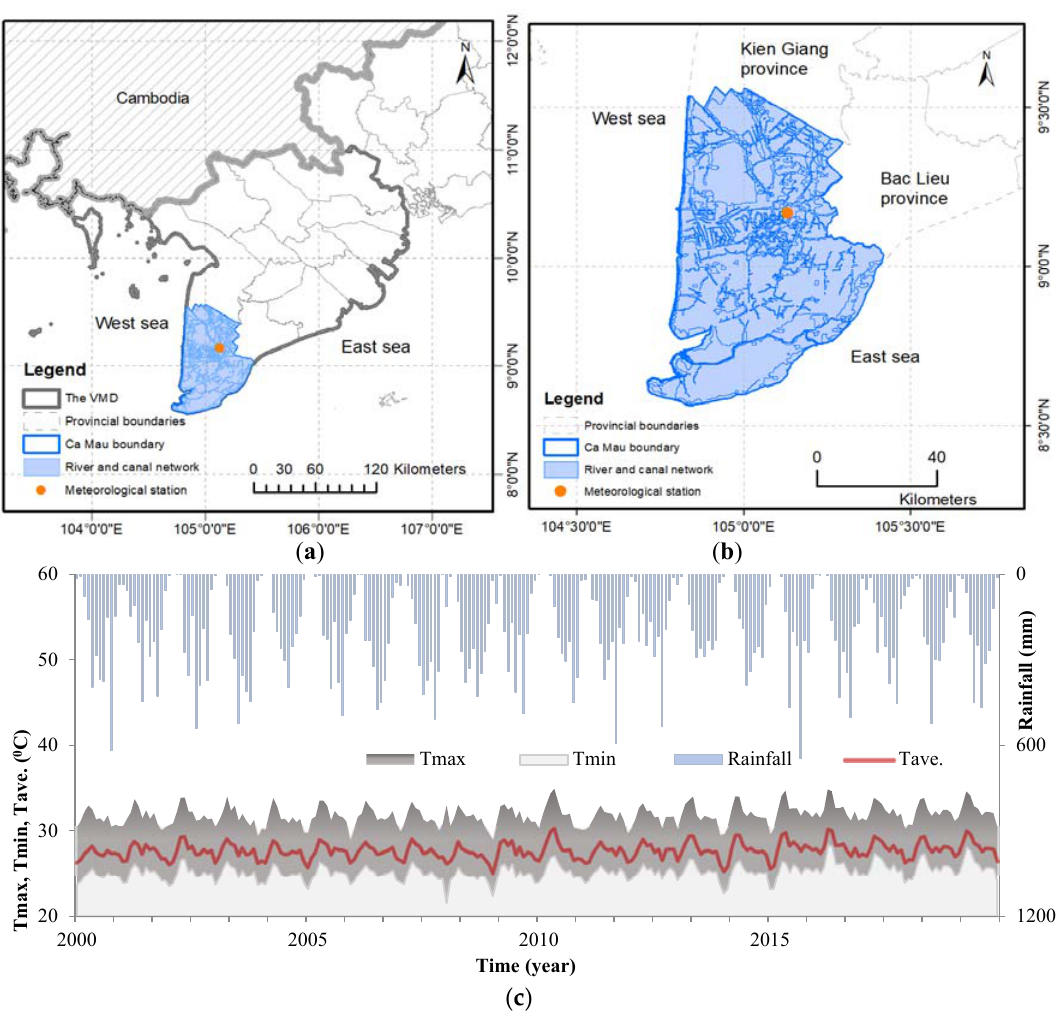
Figure 1. Location of Ca Mau province ( a ) and meteorological station ( b ); and T max , T min , T ave , and rainfall distribution between the years 2000 and 2019 ( c